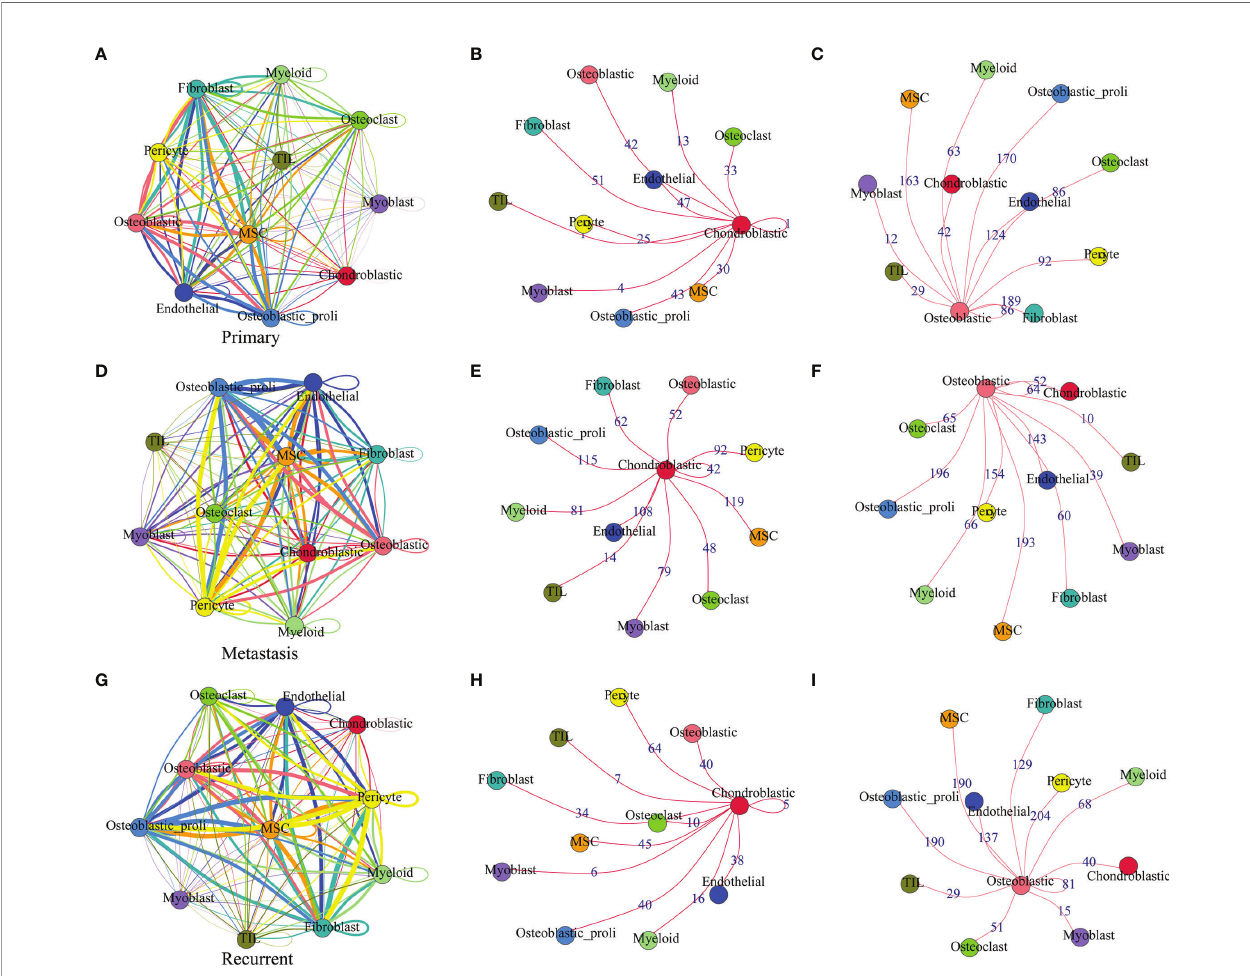
FIGURE 3 | Cell – cell communication network among different cell types in primary, metastatic, and recurrent osteosarcomas. (A) The cell – cell communication network among different cell types in primary osteosarcoma. (B) The communication network between chondroblastic cells and other types of cells in primary osteosarcoma. (C) The communication network between osteoblastic cells and other types of cells in primary osteosarcoma. (D) The cell – cell communication network among different cell types in metastatic osteosarcoma. (E) The communication network between chondroblastic cells and other types of cells in metastatic osteosarcoma. (F) The communication network between osteoblastic cells and other types of cells in metastatic osteosarcoma. The thickness of the line or the number on the line is proportional to the number of ligand – receptor pairs connecting the two cell types. (G) The cell – cell communication network among different cell types in recurrent osteosarcoma. (H) The communication network between chondroblastic cells and other types of cells in recurrent osteosarcoma. (I) The communication network between osteoblastic cells and other types of cells in recurrent